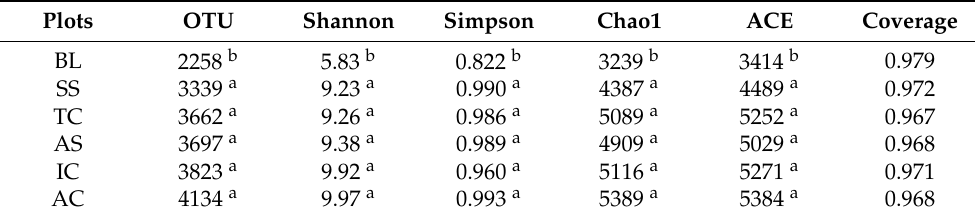
Table 2. The alpha diversity index of soil bacterial communities in the study area.